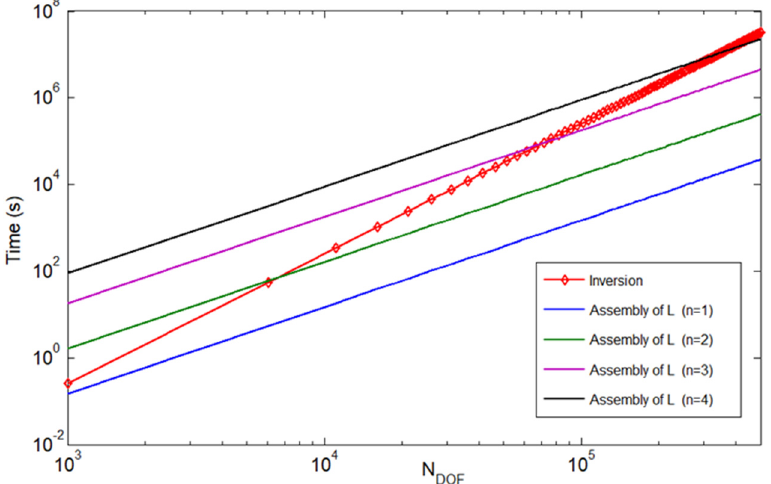
Figure 1. Benchmark case study: times required for the inversion of (6) and for the assembly of L versus the number of degrees of freedom, N dof . The assembly times are parametrized to the number of Gauss points, n .